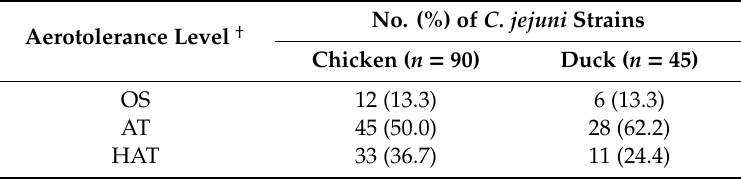
Table 2. Aerotolerance in C. jejuni strains isolated from retail raw chicken and duck meat. Aerotolerance Level †